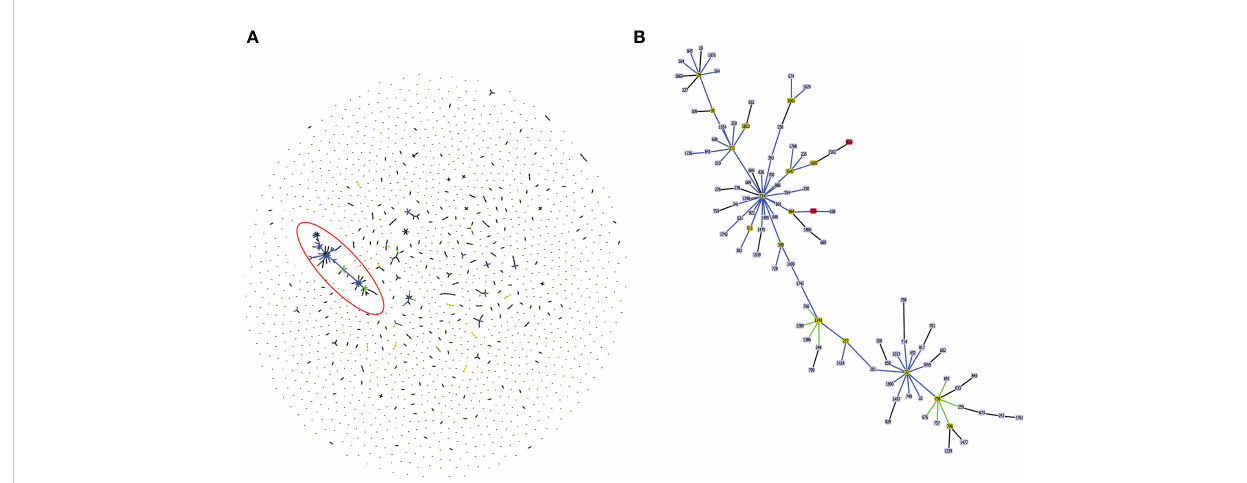
FIGURE 2 (A) Population structure analysis of available sequence types (ST) of Burkholderia cepacia complex in pubMLST database. The single ST represented by dot. Groups that are double locus variants linked by STs form clonal complex (CC). The largest CC31 is highlighted in the red eclipse. (B) Zoom image of the CC31, which is highlighted in (A) . Color code used by goeBURST tool indicates: Light blue, red node color - Common node, Dark Green node color-Sub-group founder, Light green node color- Group